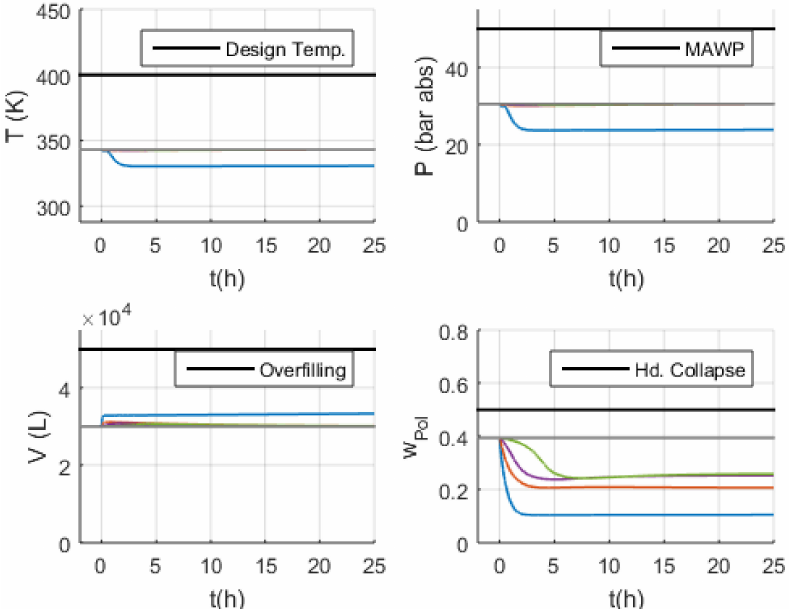
Figure 17. Behavior of critical variables in scenario S-3 with Model 2. Make-up flow: ( ) maximum flow; ( ) 150% of normal flow; ( ) 110% of normal flow; ( )101% of normal flow; ( ) normal.